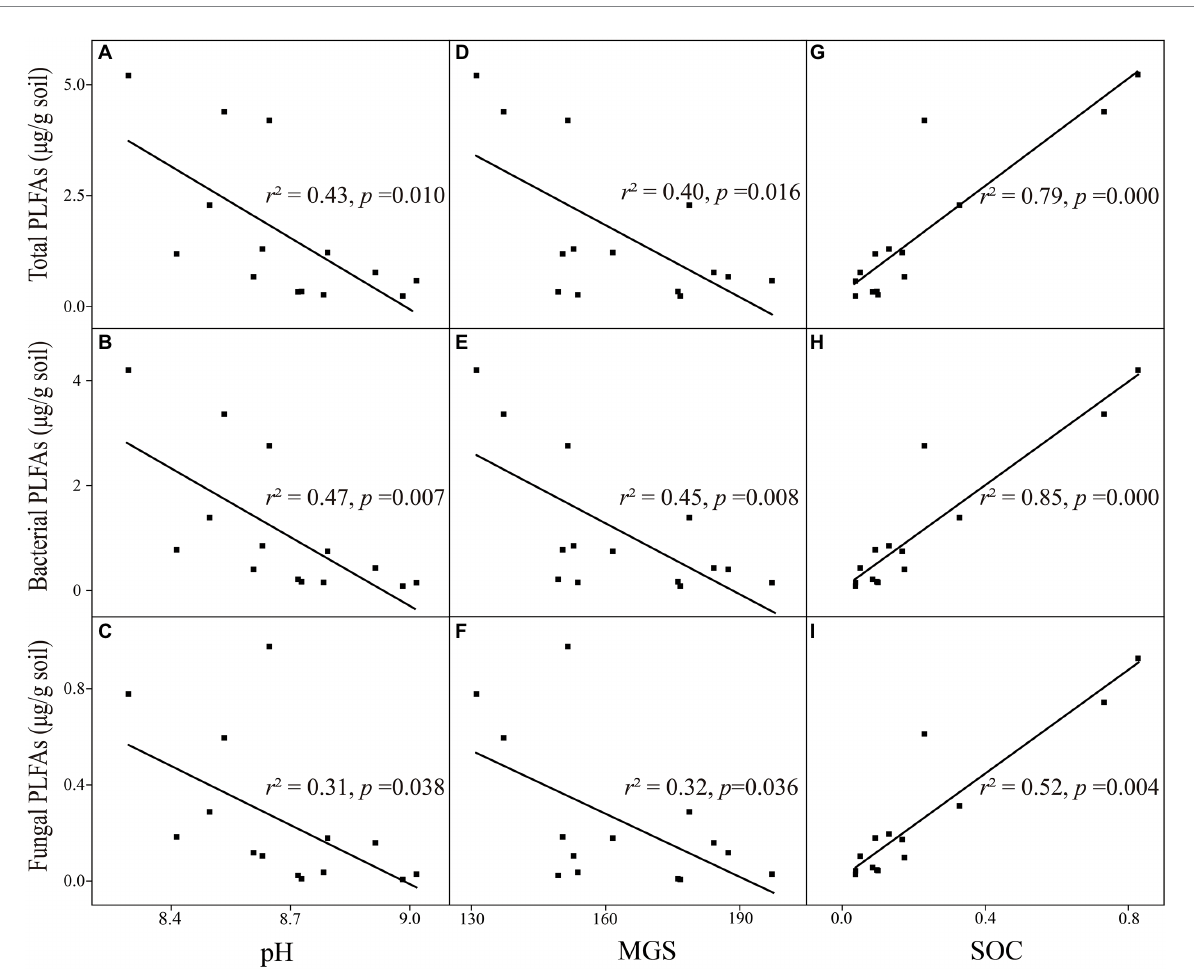
FIGURE 4 Relationships between environmental factors and microbial properties in the alpine desert. ( A–C ) pH with total PLFAs, bacterial PLFAs and fungal PLFAs. ( D–F ) mean grain size (MGS) with total PLFAs, bacterial PLFAs and fungal PLFAs. ( G–I ) soil organic carbon (SOC) with total PLFAs, bacterial PLFAs and fungal PLFAs. R squared (r 2 ) represents the fit degree of linear regression, p < 0.05 indicates significant